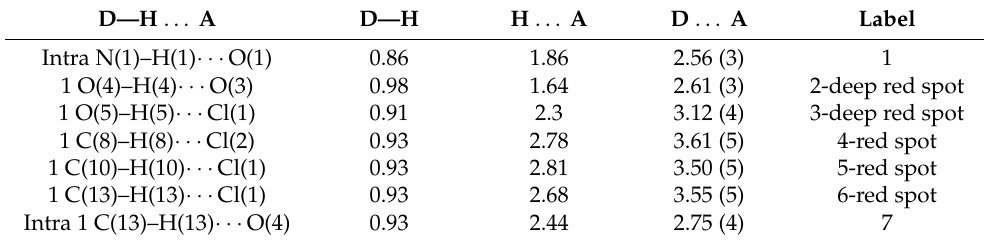
Figure 2. ( a ) A view of intermolecular and intramolecular interaction in the crystal packing along with the crystallographic axis c propagated H-bonding interactions. ( b ) A close view of H-bonding in complex 1, represented by dotted lines along with bond length within the crystal. Table 2. Classical hydrogen bond geometry (Å) in crystal of complex 1 .